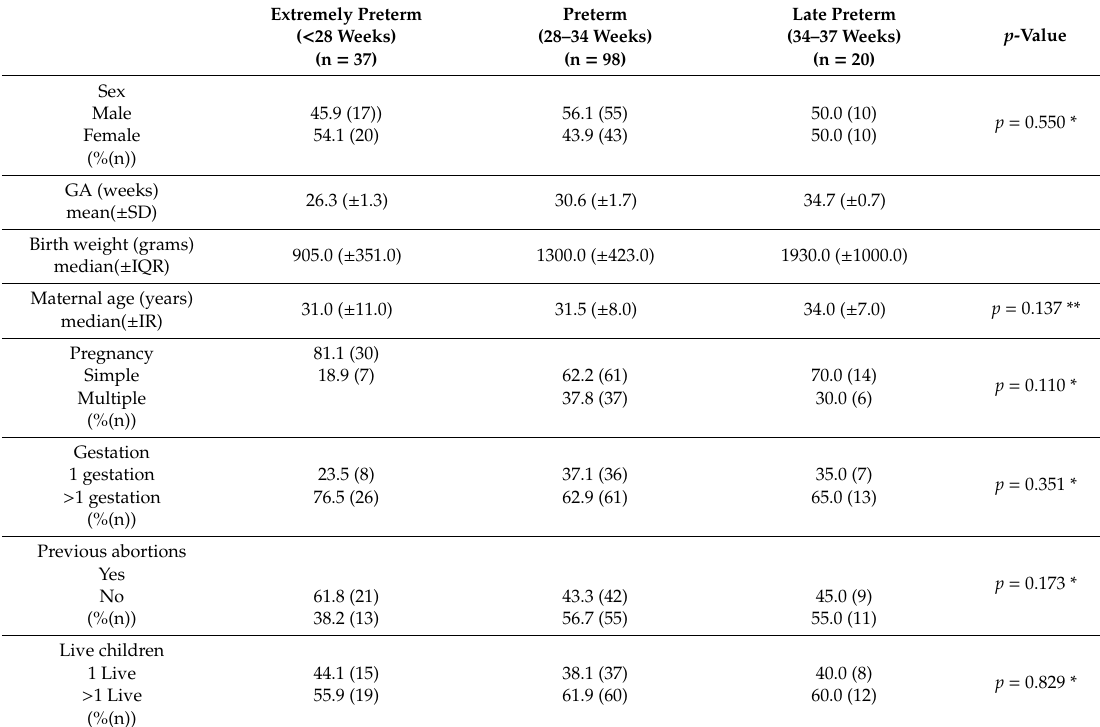
Table 1. Sociodemographic variables and maternal history.